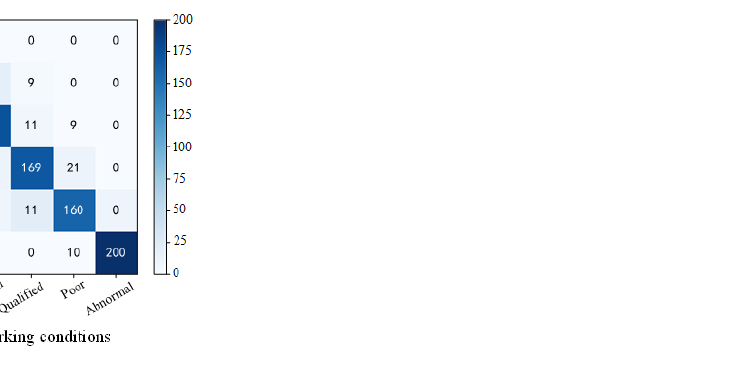
Figure 17. Performance recognition results of three modes. ( a ) Foam flotation condition identification combining multi-scale CNN and LBP features; ( b ) Multi-scale NSST-CNN condition identification; ( c ) LBP-TOP condition identification.